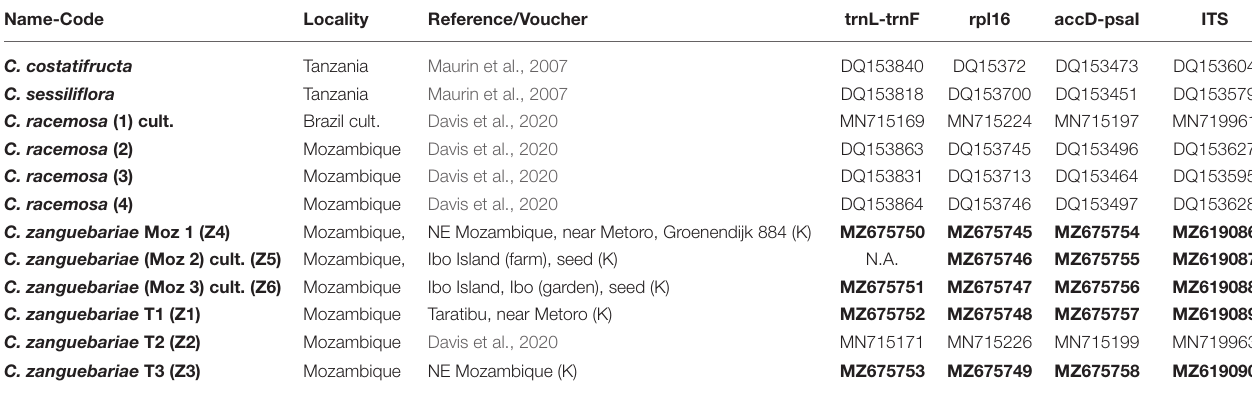
TABLE 1 | List of DNA sampling and accession